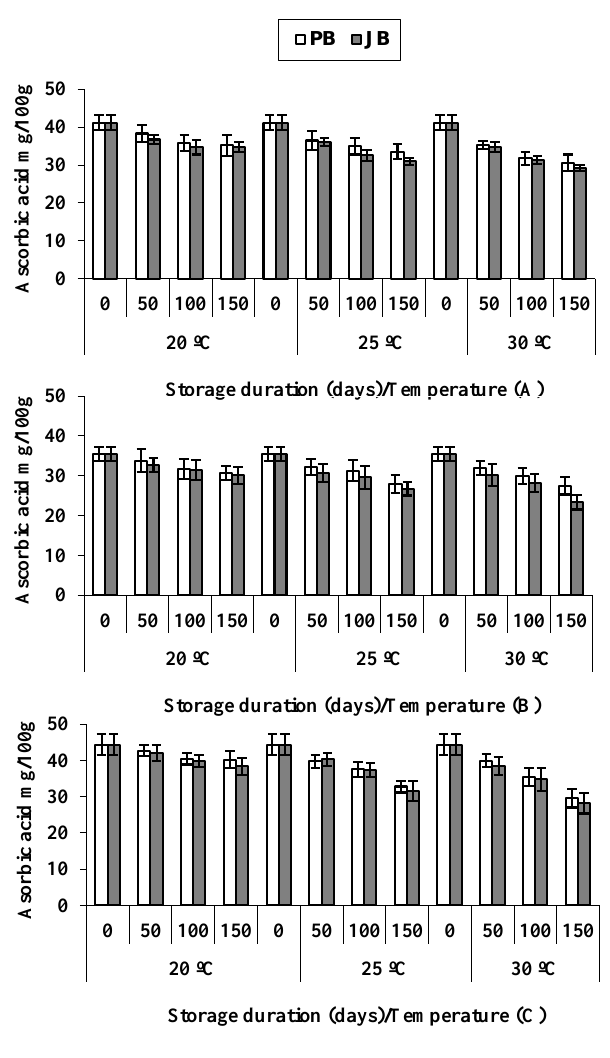
Figure 3. Ascorbic acid in hot peppers viz . Sky Red ( A ), Maha ( B ) and Wonder King ( C ) at different temperatures and packaging materials during five months’ storage. Vertical bars show ± SD of n = 3